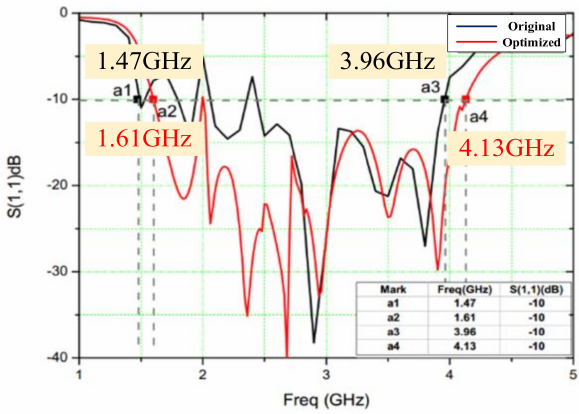
Figure 14. Transmitting antenna S11 before and after optimization.